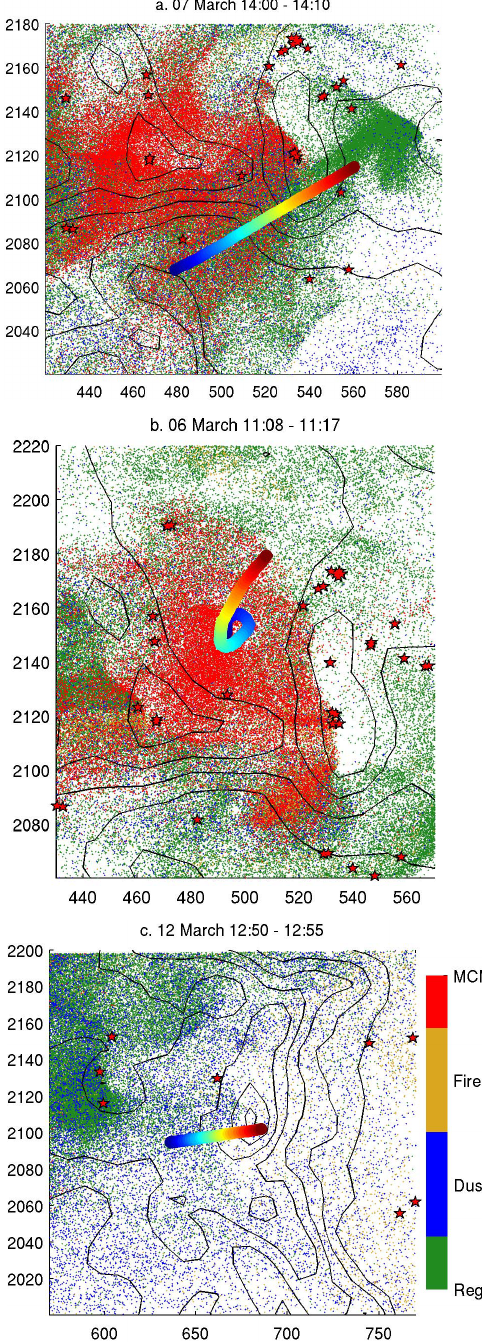
Fig. 3. Flexpart particle clouds colored by emission source using the colorbar in (c) . The path of the HSRL curtain plots is shown by the colored line. The corresponding profile can be found by match- ing the color along the flight path with the colorbar across the top of the curtain plots. (a) corresponds to Fig. 4, (b) to Fig. 5 and (c) to Fig. 6. Stars indicate burning fires. Axes show Universal Trans- verse Mercator zone 14 coordinates in kilometers. Terrain contours shown every